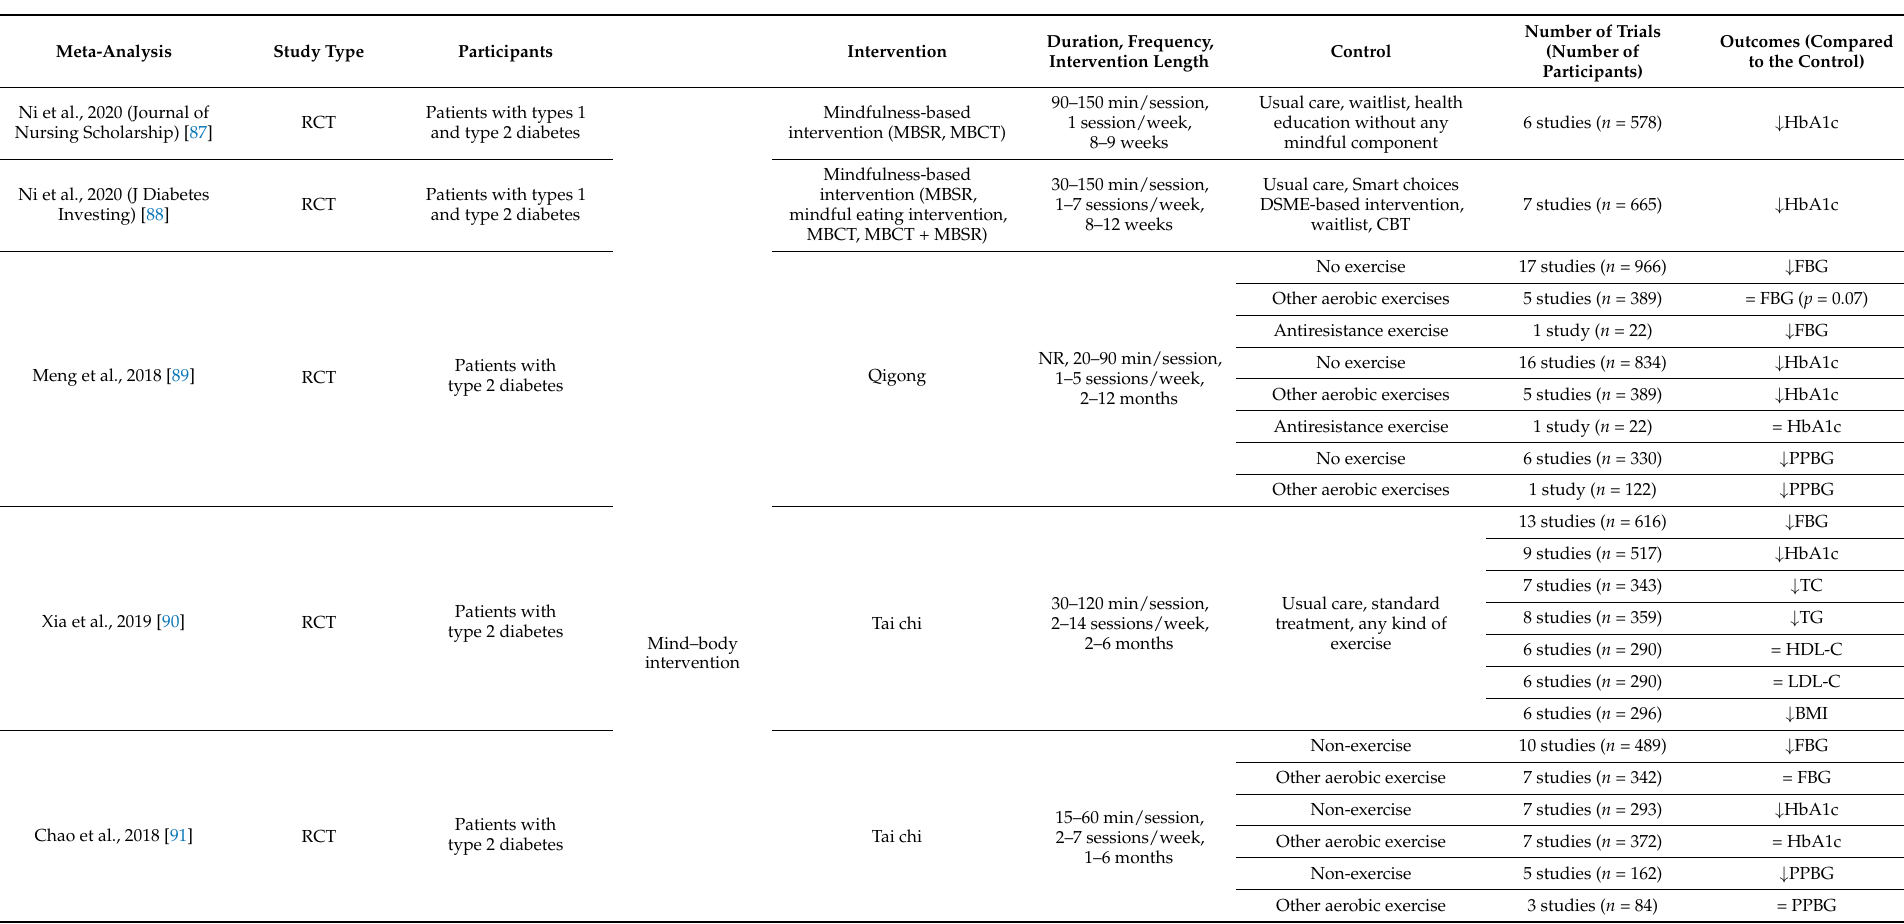
Table 1. Recent meta-analyses about the effects of mind–body intervention and other protocols on regulation of blood glucose and lipid